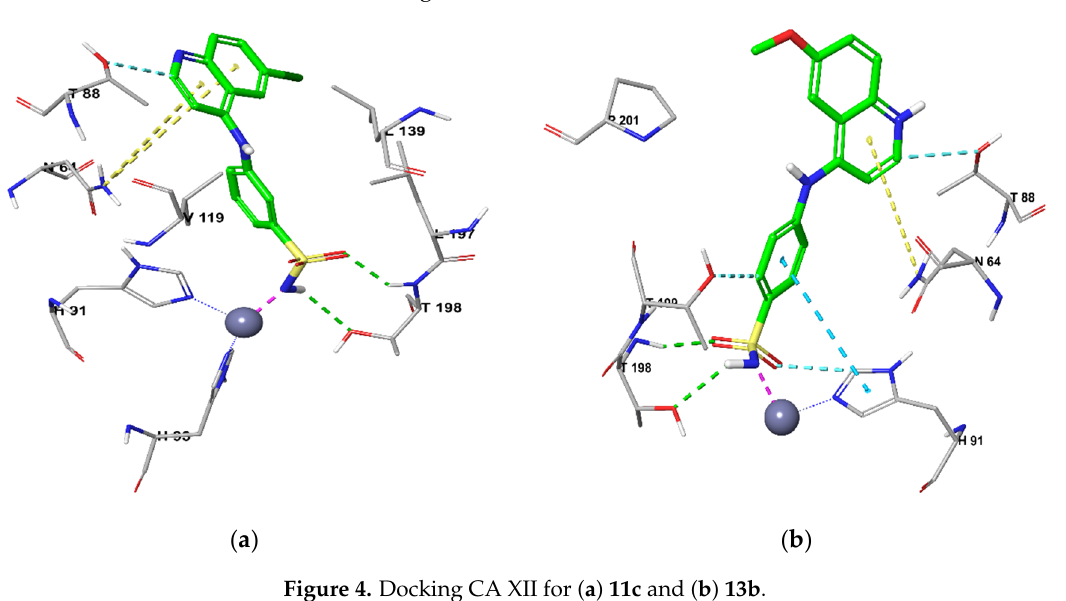
Figure 4. Docking CA XII for ( a ) 11c and ( b ) 13b .